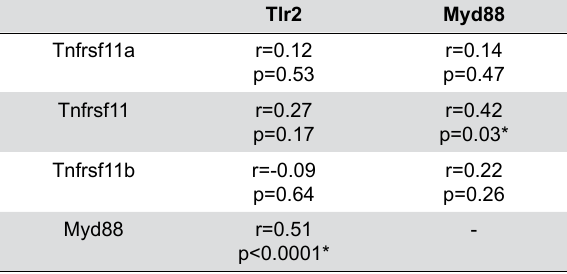
*bold indicates statistical difference (p<0.05)